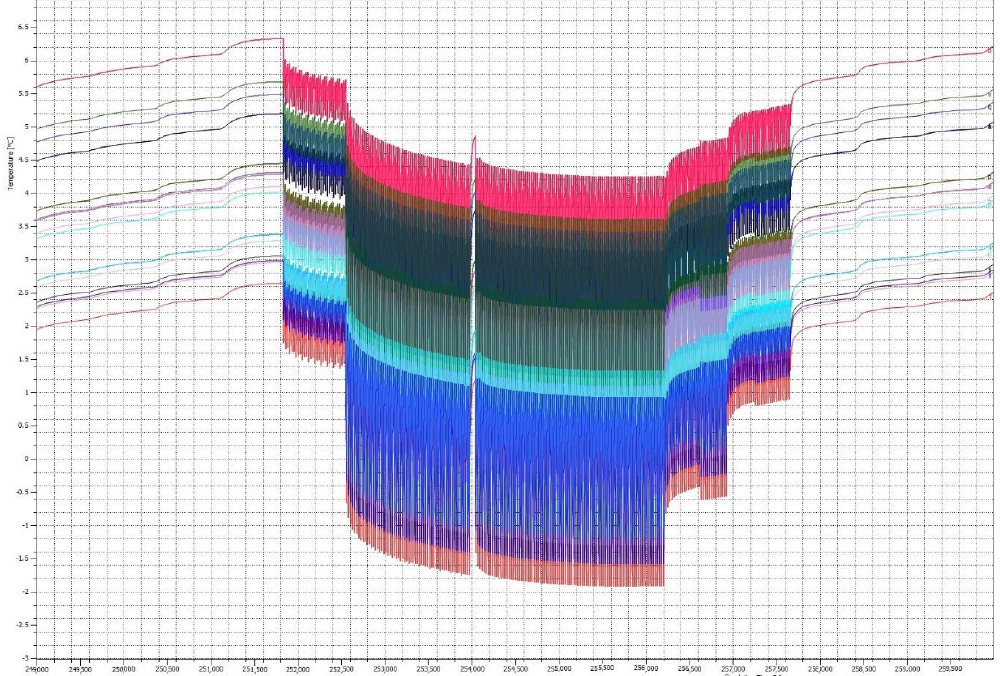
Figure 15. Average temperature of BHEs within the 3rd scenario (system without cooling) during the 30th year of